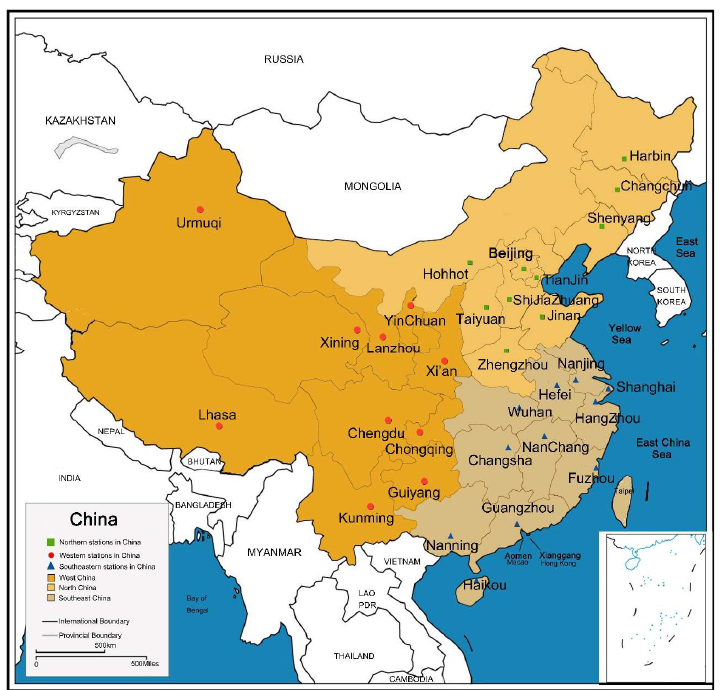
Figure 1. Locations of 31 provincial capital cities in China.